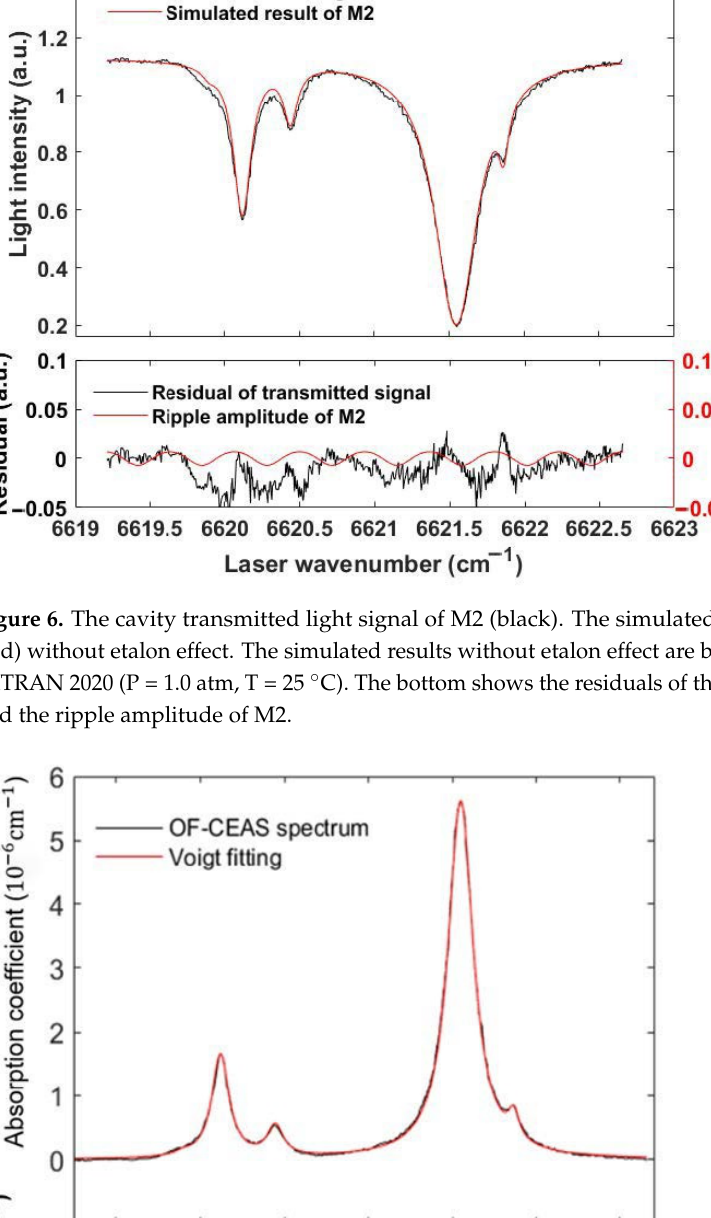
Figure 7. The absorption coefficient spectrum (black) and Voigt fitting of the absorptions of molecular H 2 O (red) based on HITRAN 2020 (P= 1.0 atm, T = 25 °C); the bottom shows the fit residual.